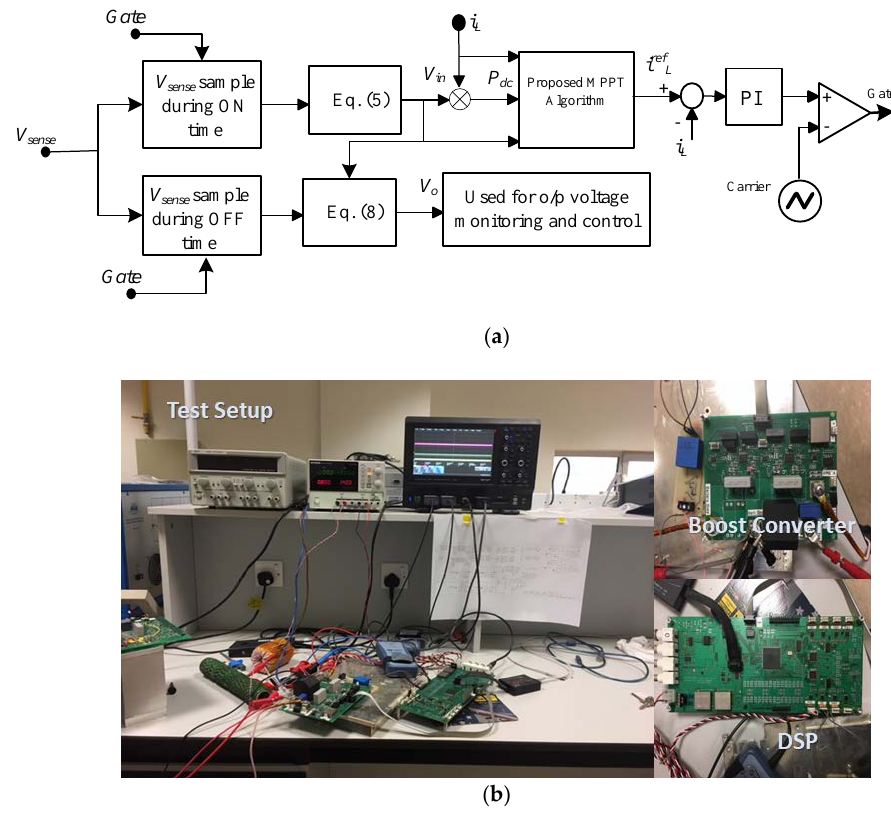
Figure 7. ( a ) Schematic diagram of the TEG energy-harvester control diagram. ( b ) Hardware photo of the test setup.